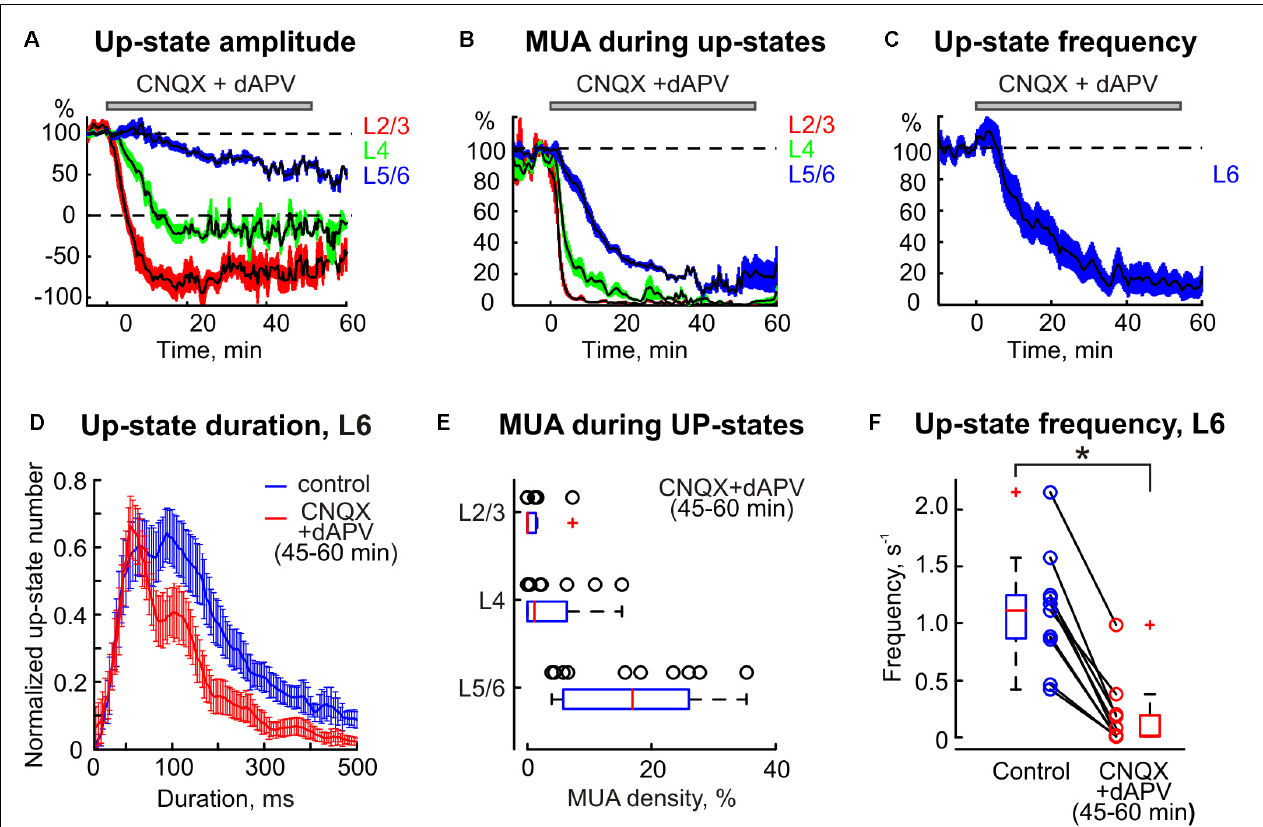
FIGURE 6 | The statistical data on CNQX and dAPV action on spontaneous barrel cortex activity. The decrease in up-states amplitude (A) , MUA density during up-states (B) , and up-states frequency (C) in different layers of the cortical barrel column following application of CNQX/dAPV (application time shown with gray bar above each plot). The colored areas surrounding each curve show SE bands. (D) The up-state duration distribution in control and after the drugs application. (A–D) Show averaged data from 11 animals and two concentrations, 170 µ M CNQX/700 µ M dAPV and 0.5 mM CNQX/2 mM dAPV. (E) Group data on normalized MUA density in different cortical layers during a steady state of CNQX and dAPV effect. (F) Group data on up-states frequency in control and after CNQX/dAPV application. The open circles on (E,F) correspond to individual experiments, and the red line on boxplots is a median. ∗ p <